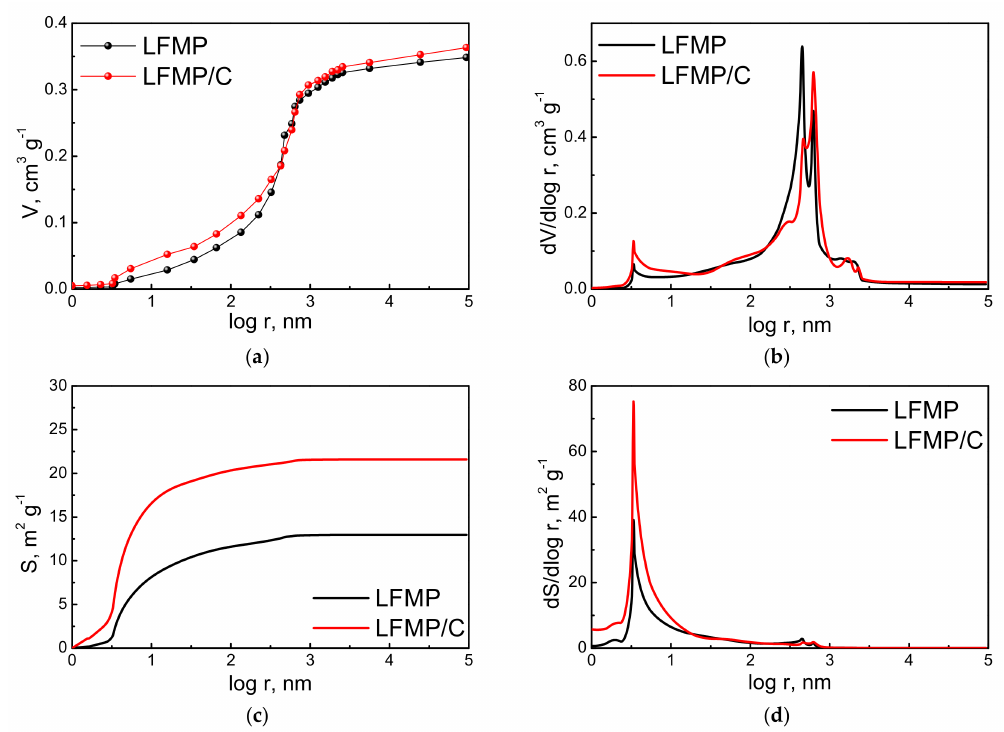
Figure 4. Integral ( a ) and di ff erential ( b ) pore volume distribution and surface distribution ( c , d ) vs. pore radius for LFMP and LFMP /